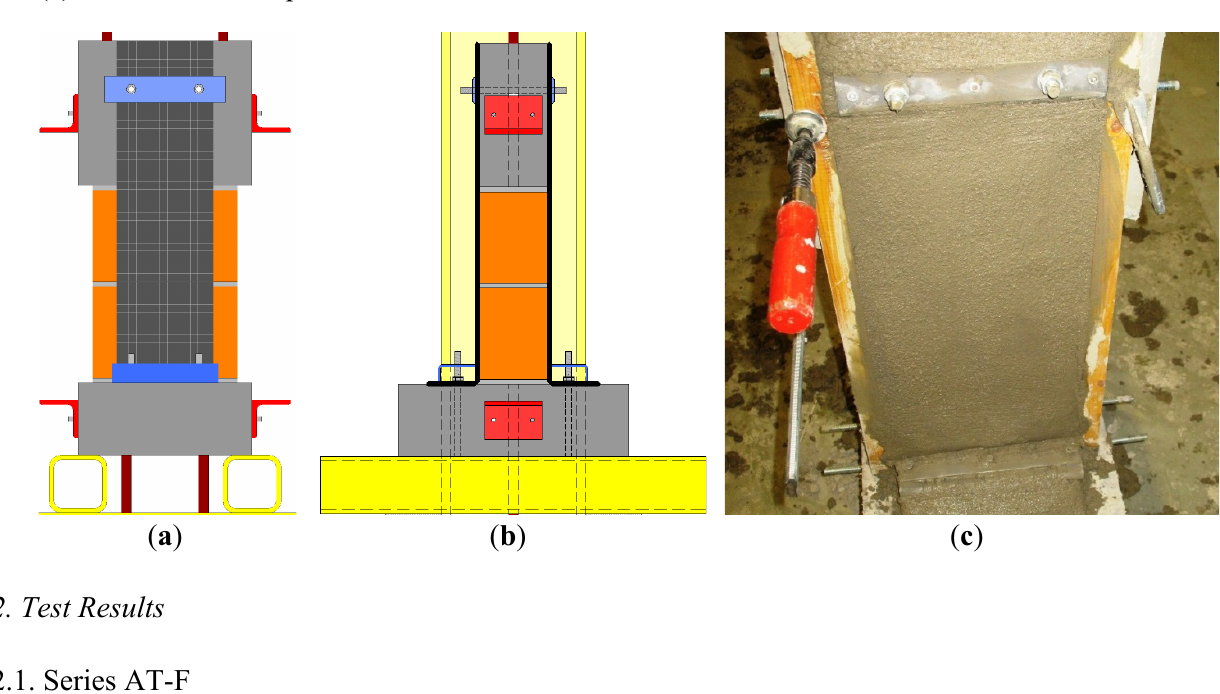
Figure 13. ( a , b ) Model of specimen in Series AT-G in view and sectional drawing; and ( c ) Construction of specimen in Series AT-G.